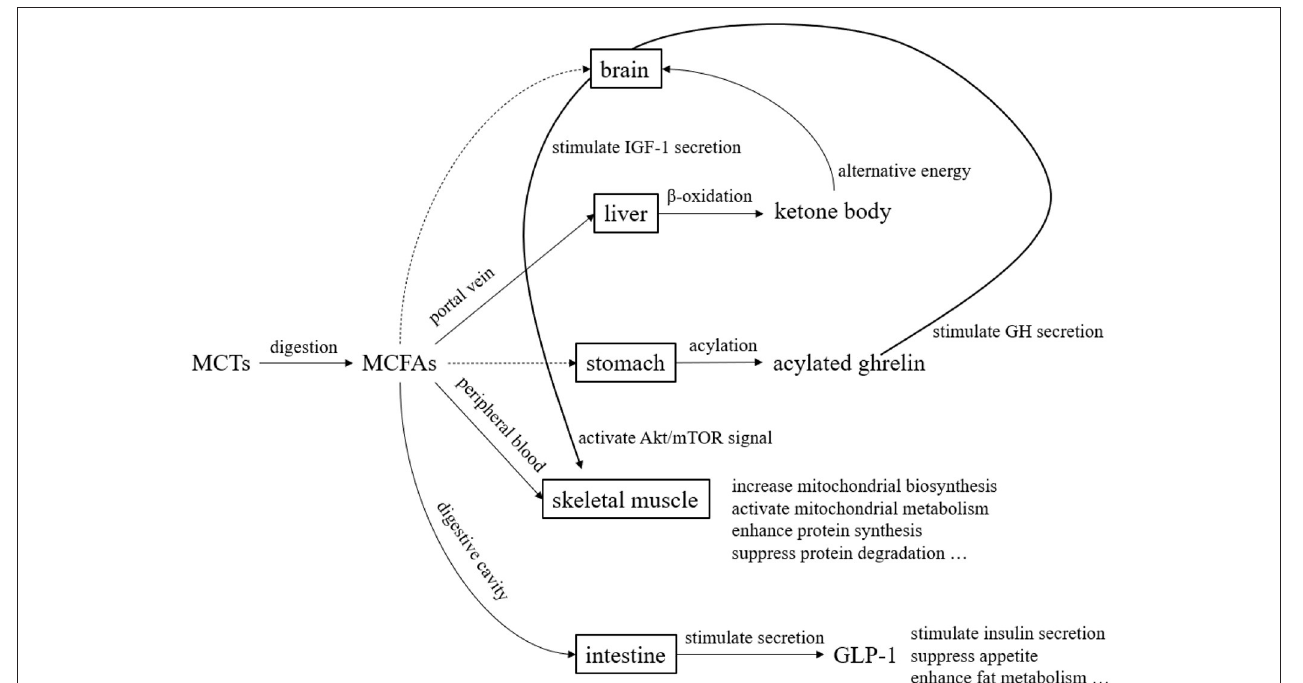
FIGURE 5 | Overview of metabolism and functional expression of MCTs. MCTs are mostly transported to the liver via the portal vein after digestion and absorption. Since MCTs do not require carnitine for transfer to the mitochondria, they are quickly beta-oxidized and become energy. During this process, ketone bodies are produced, which serve as an alternative energy source to glucose in the brain. Although the pathway is unknown, acylated ghrelin levels in the blood increase after MCTs ingestion. Acylated ghrelin enhance the secretion of growth hormone (GH), which in turn stimulates the secretion of insulin-like growth factor 1 (IGF-1). Furthermore, IGF-1 enhance protein synthesis and suppress protein degradation by activating Akt/mTOR signaling. MCFAs transferred to the peripheral blood act on skeletal muscle to enhance mitochondrial biosynthesis and mitochondrial metabolic activity. MCFAs also stimulates the secretion of glucagon-like peptide 1 (GLP-1) from small intestinal L cells.